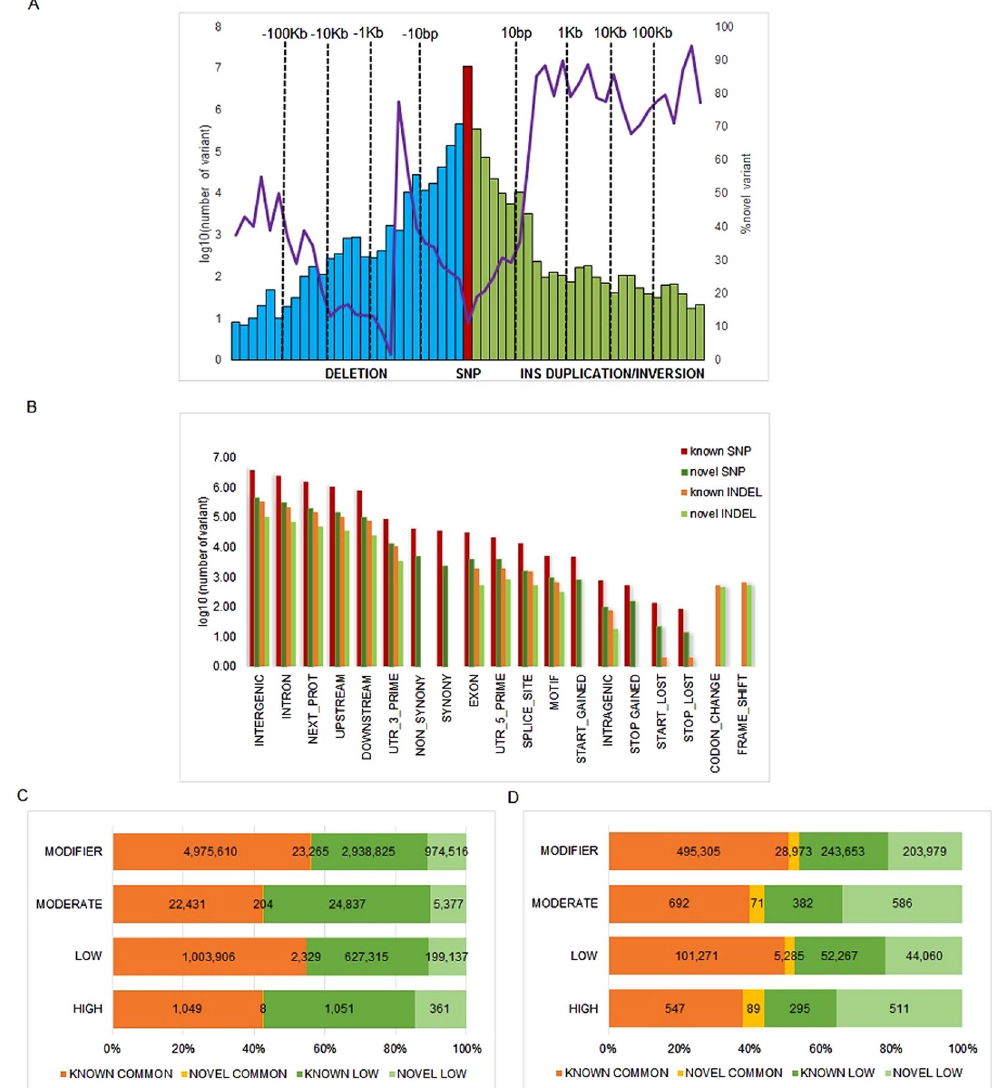
Figure 1. Variants discovered from high coverage DNA whole genome sequencing on 48 JIA individuals. ( A ) Bars show variant numbers (log10) stratified by sizes (horizontal axis) for different type of variant, SNPs are in brown, indels consisting of insertions (green) and deletions (blue). Structural variations (SV, size > 50 bp) in blue represent deletions, green bars are duplications (inversion). The purple line indicates variant novelty rate in percentage. Novelty is defined with respect to dbSNP141 for SNPs and indels whereas novelty for SV is determined by comparing to Database of Genomic Variants archive. ( B ) SNP and indel distribution by genomic features grouped by novelty. Variant distribution based on alternative allele frequency (common > 5%, low ≤ 5%) and variant effects predicted by SNPEff for SNPs ( C ) and indels ( D